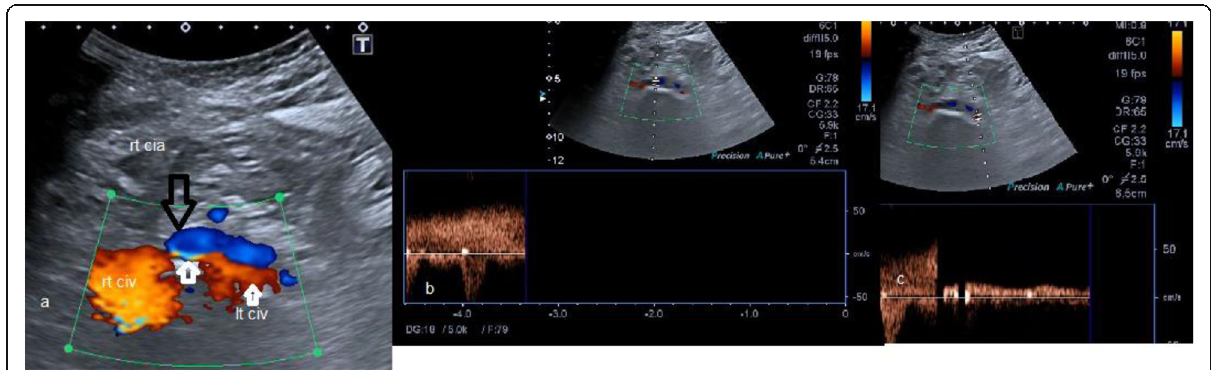
Fig. 9 a – c trans-abdominal color and spectral Doppler images showing significant compression of the left common iliac vein (lt.civ.) (Open white arrows in a) by the right common iliac artery (rt. cia.) with significant rise in the velocity ratio that was measured in the b compressed segment as compared with the preceding c uncompressed segment